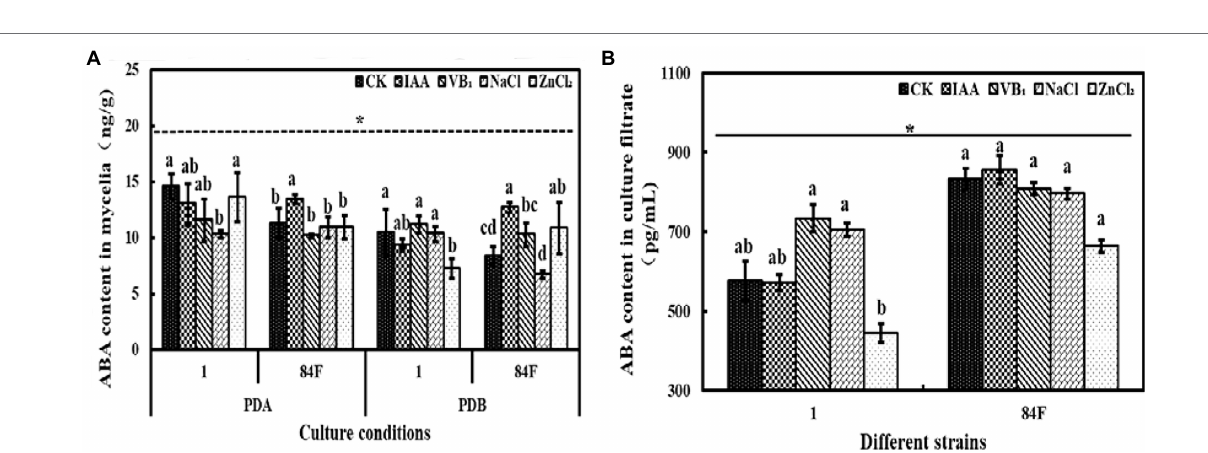
FIGURE 5 | Abscisic acid content of E. sinensis under different treatments for 4 weeks. (A) is ABA content in mycelia, and (B) is ABA content in culture filtrate. The same as Figure 1